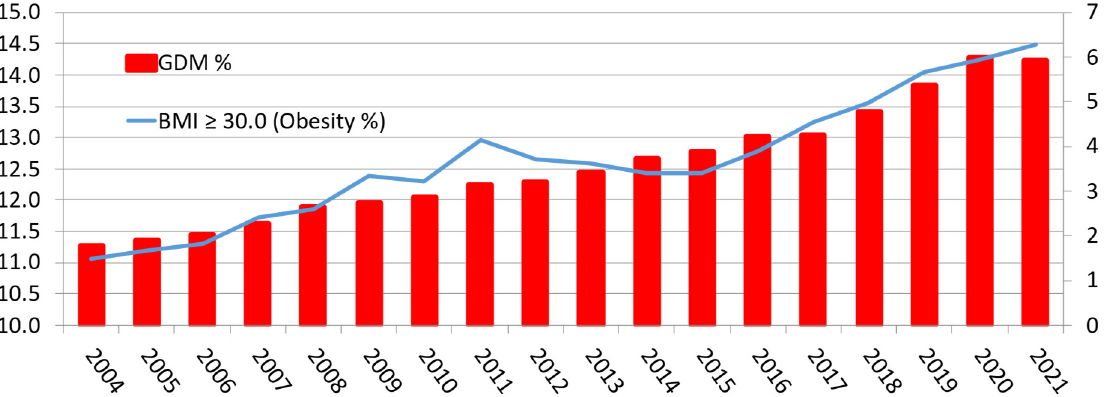
Figure 3. Gestational Diabetes Mellitus (GDM) and BMI ≥ 30 in Denmark 2004–2021 (%) (The Danish Health Data Agency (Sundhedsdatastyrelsen) 2022). “x” axis—Year; Left sided “y” axis—% Pregnant women with BMI ≥ 30 kg/m 2 ; Right sided “y” axis—% Pregnant women clinically diagnosed with GDM.